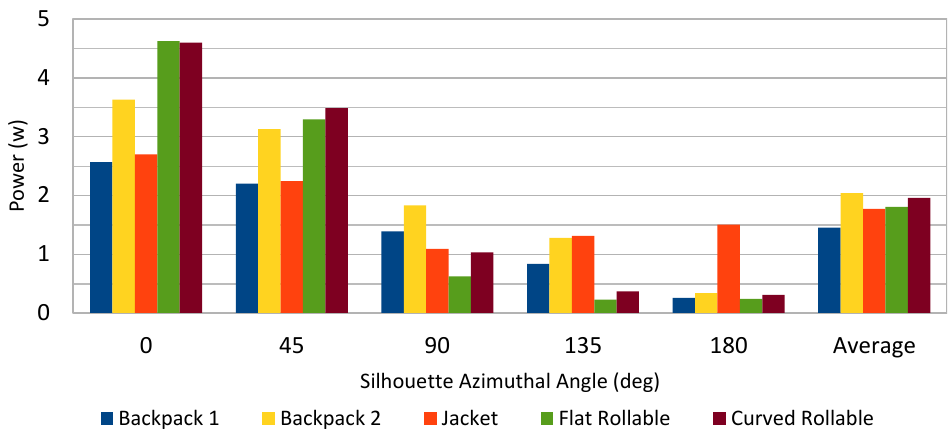
Figure 15. Power output of different PV module configurations averaged over five experiments as a function of the silhouette azimuthal angle.